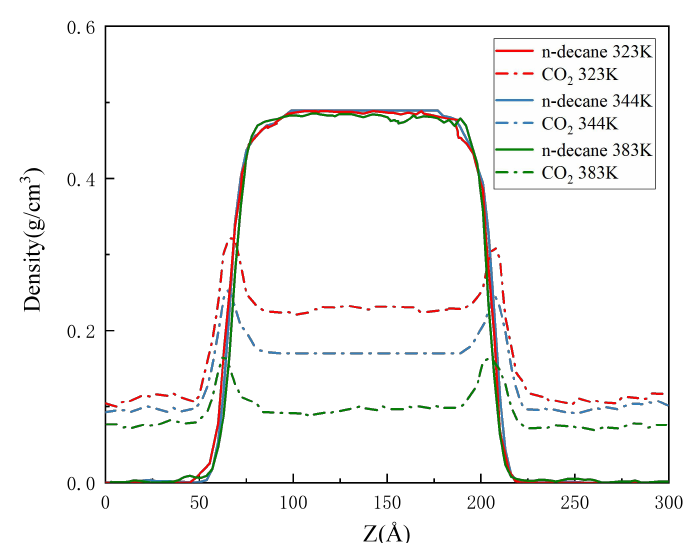
Figure 8 — The density distribution of CO 2 /n-decane at 4.5